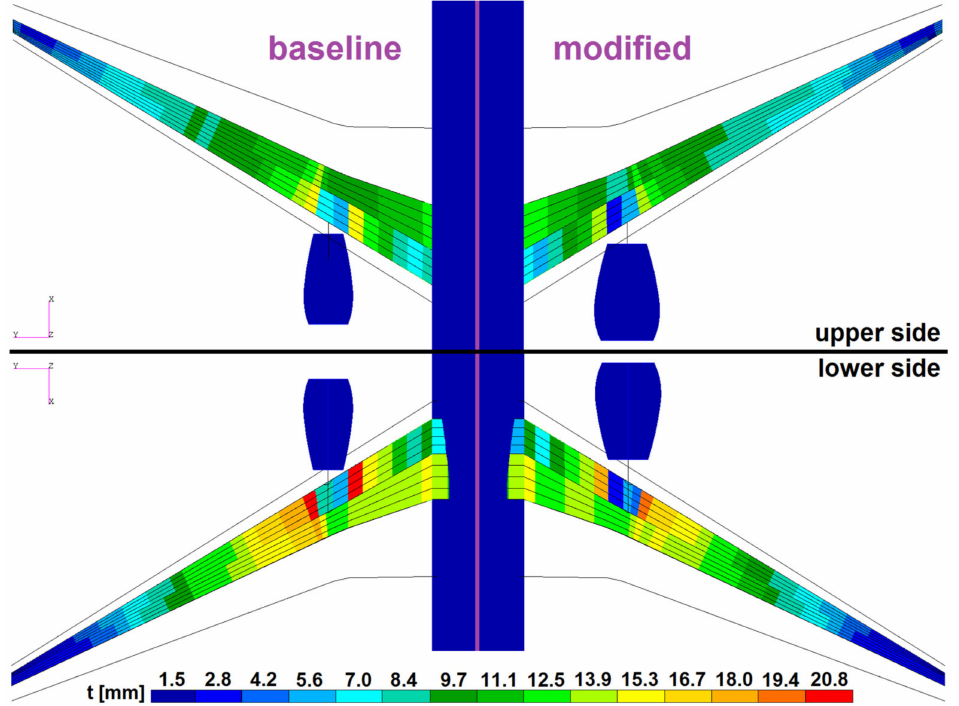
Figure 13. Converged thickness distribution of the upper and lower skin—baseline left; modified